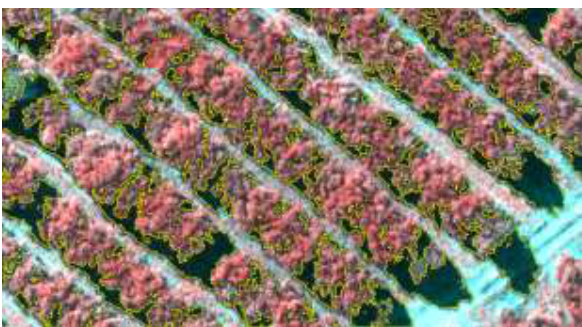
Figure 10. Image sample of HRcube color composition overlapped to the polygons which represent shadow Figures 11 and 12 present graphics of the maximum, minimum and mean values extracted from both samples.